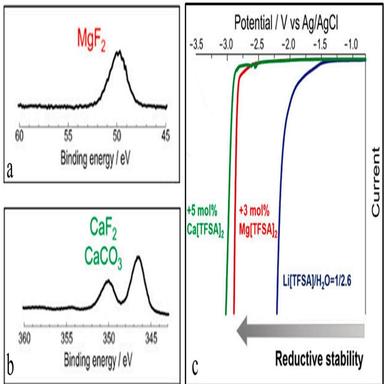
Increased stability by passivation of the anode with added divalent ions. XPS spectra of Al electrodes after the cathodic polarization for (a) Mg 2p in Li–Mg binary salt hydrate and (b) Ca 2p in Li–Ca binary salt hydrate. (c) Linear sweep voltammograms of Li salt molten hydrate, Li–Mg binary salt hydrate and Li–Ca binary salt hydrate at 1 mV s − 1 on Al electrode. Reproduced with permission from ACS publications.